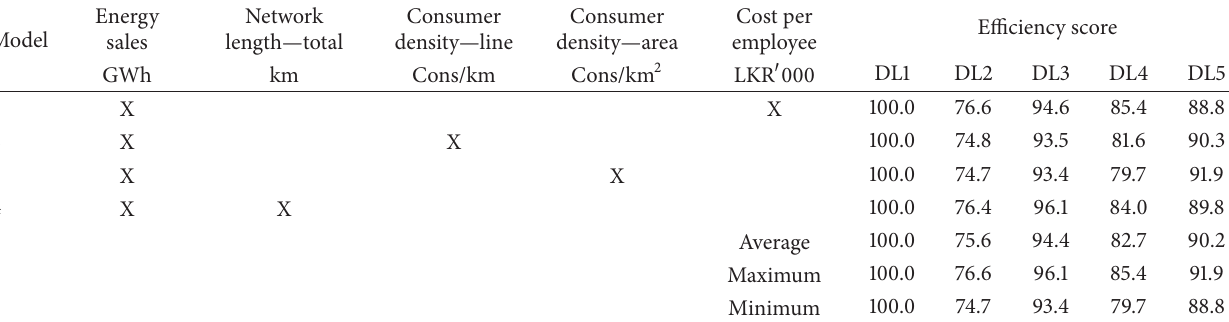
Table 8: COLS with three variables.